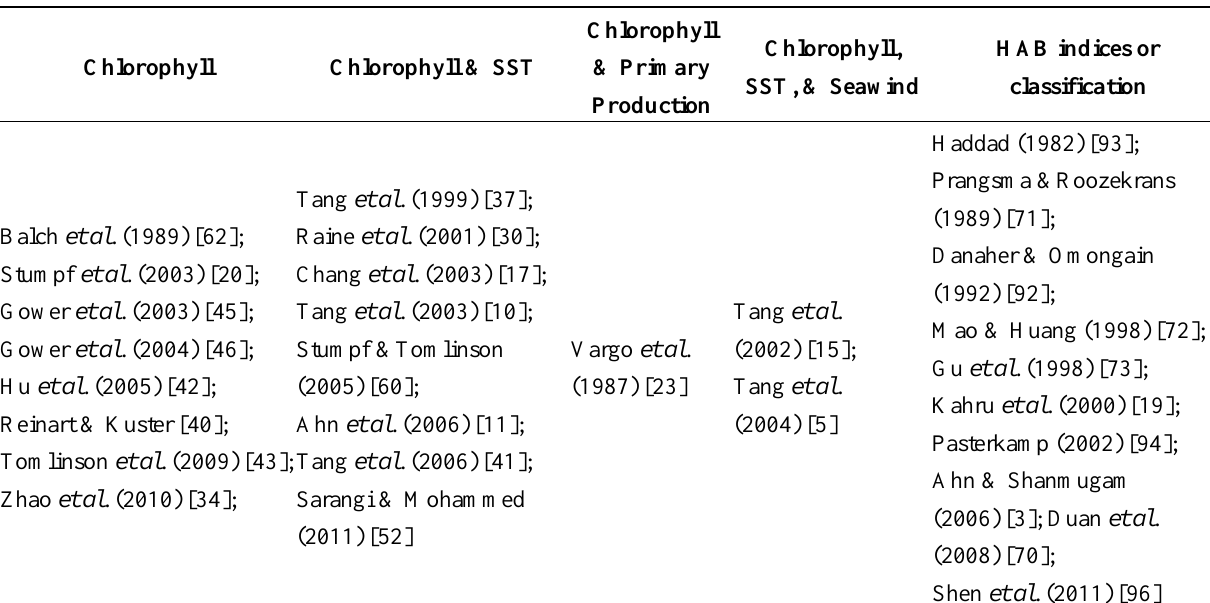
Table A1. Studies on remote sensing of HABs focusing on different